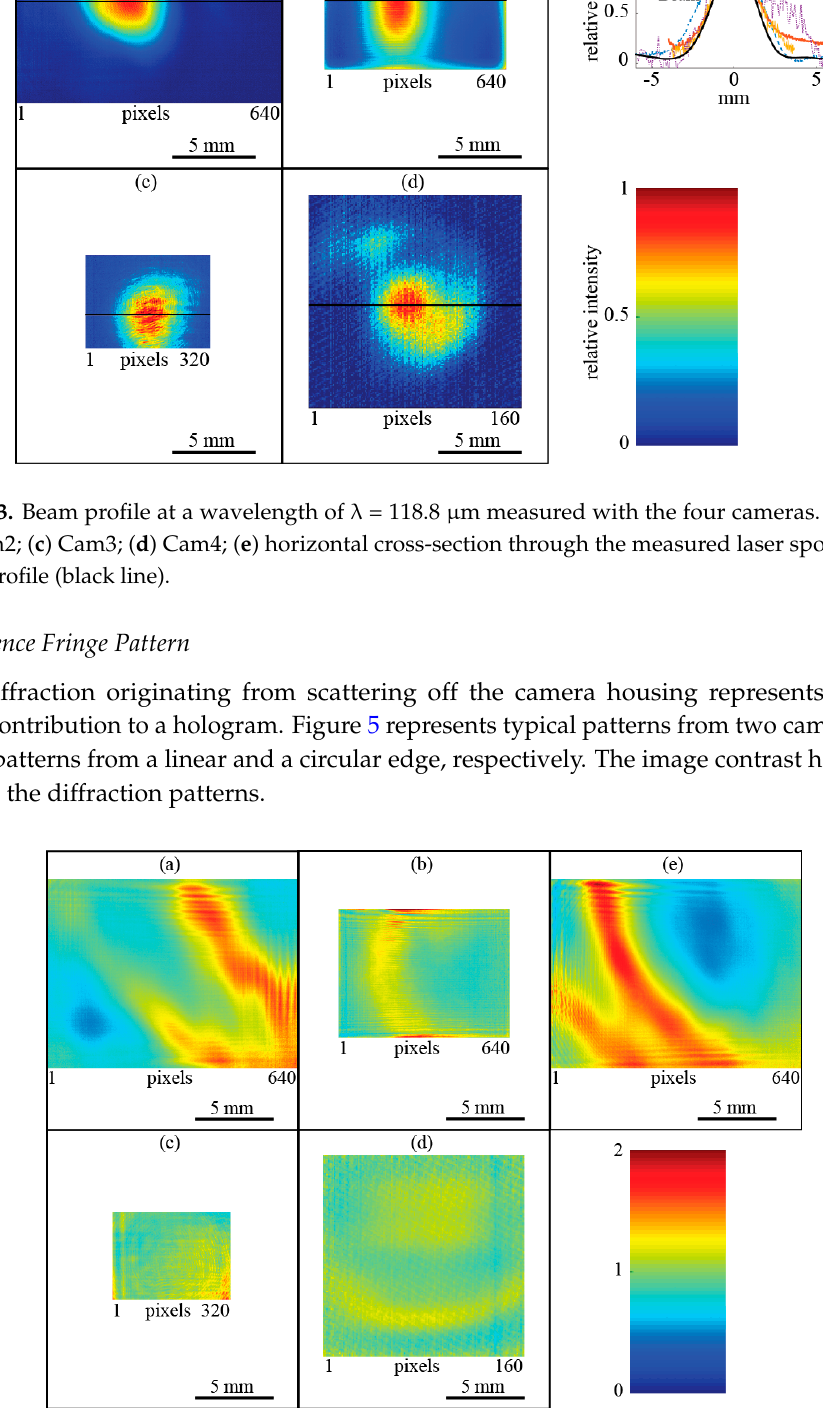
Figure 5. High frequency diffraction patterns caused by the camera housing interfering with the two ‐ beam fringe pattern, measured at λ = 118.8 μ m. Cam2 ( Left ) and Cam3 ( Right ). Figure 6 shows the central area with a size of 5 × 5 mm 2 from the original fringe patterns recorded with the four cameras. In order to determine the SNR of these fringe patterns, we remove the high frequency noise caused by edge diffraction as well as the low frequency background to obtain ideal sinusoidal fringe patterns. From these, the local modulation intensity I M is determined according to Equation (6) and is divided by the noise level. The SNR values obtained for the reference values P ref = 10 mW and τ ref = 25 ms according to Equation (5) are compiled in Table 2 for a wavelength of λ = 118.8 μ m. Note that a direct comparison of SNR ref for beam profile and interference fringes is not possible due to different experimental conditions. A considerable amount of THz power was lost in the lens system used for beam profiling, Figure 2a.